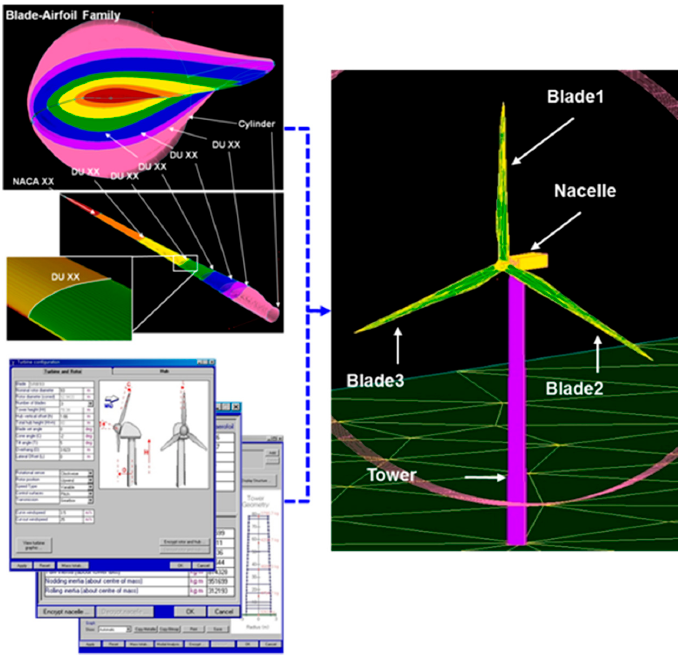
Figure 1. Three-dimensional wind turbine model.